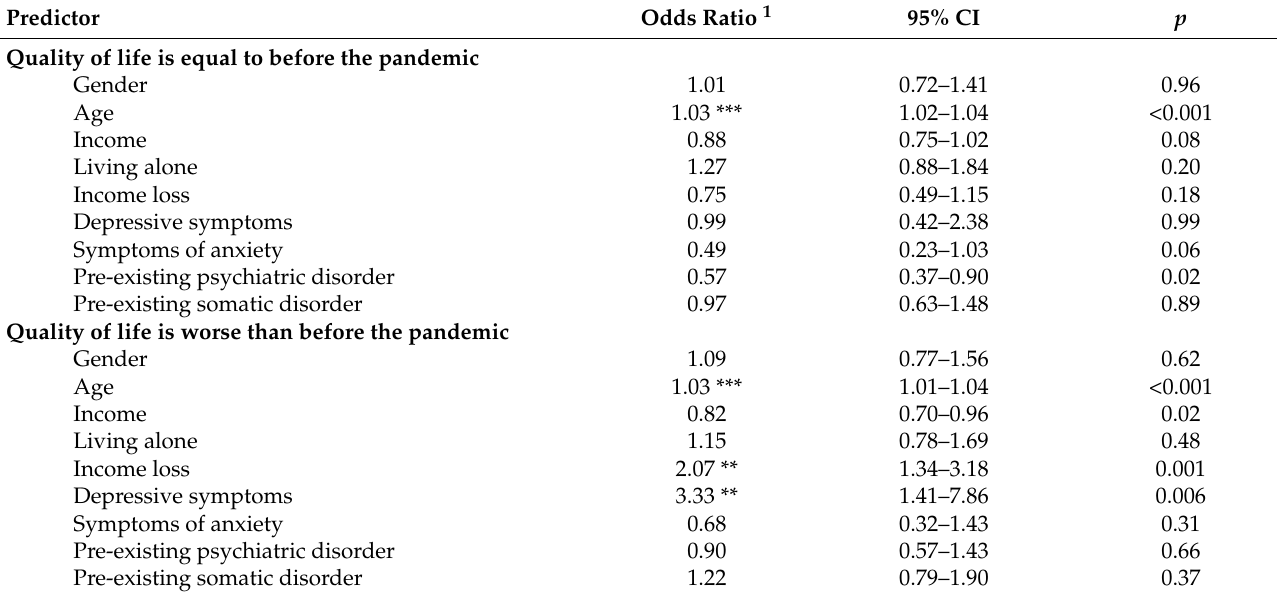
Table 4. Factors associated with equally and worse-rated quality of life compared to improvements since the beginning of the